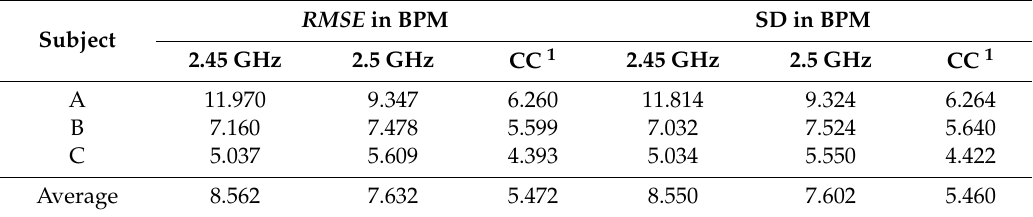
Table 2. Average root-mean-square error ( RMSE ) and standard deviation (SD) of overall heartbeat per minute measured for each subject by using the proposed FSK radar.